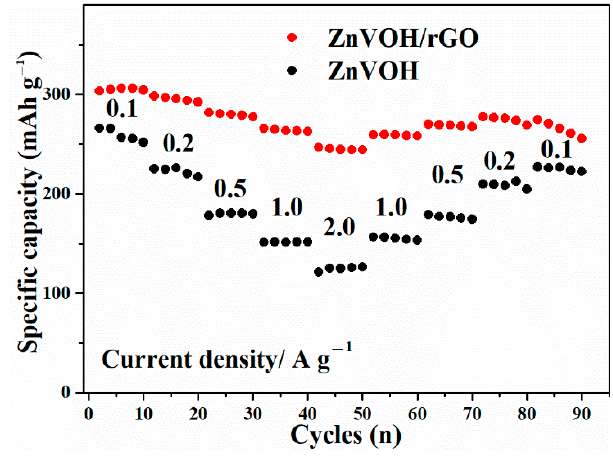
Figure 6. The rate performances of ZnVOH and ZnVOH/rGO.